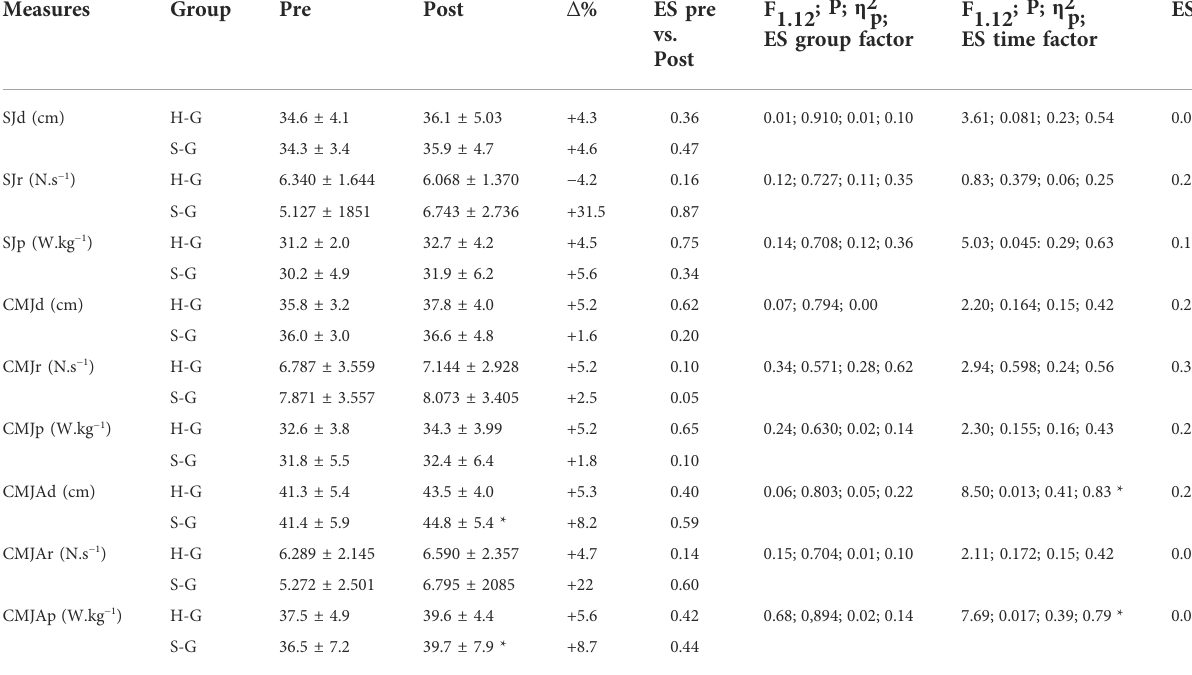
TABLE 2 Measures of jump-related performance in both groups analysed ( n = 14).